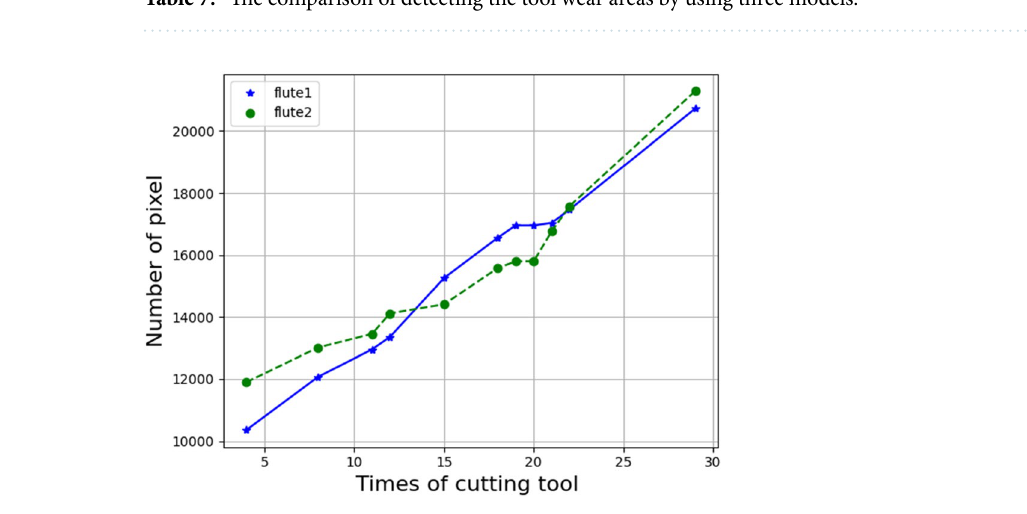
Figure 9. The experimented trend of the cutting tool wear